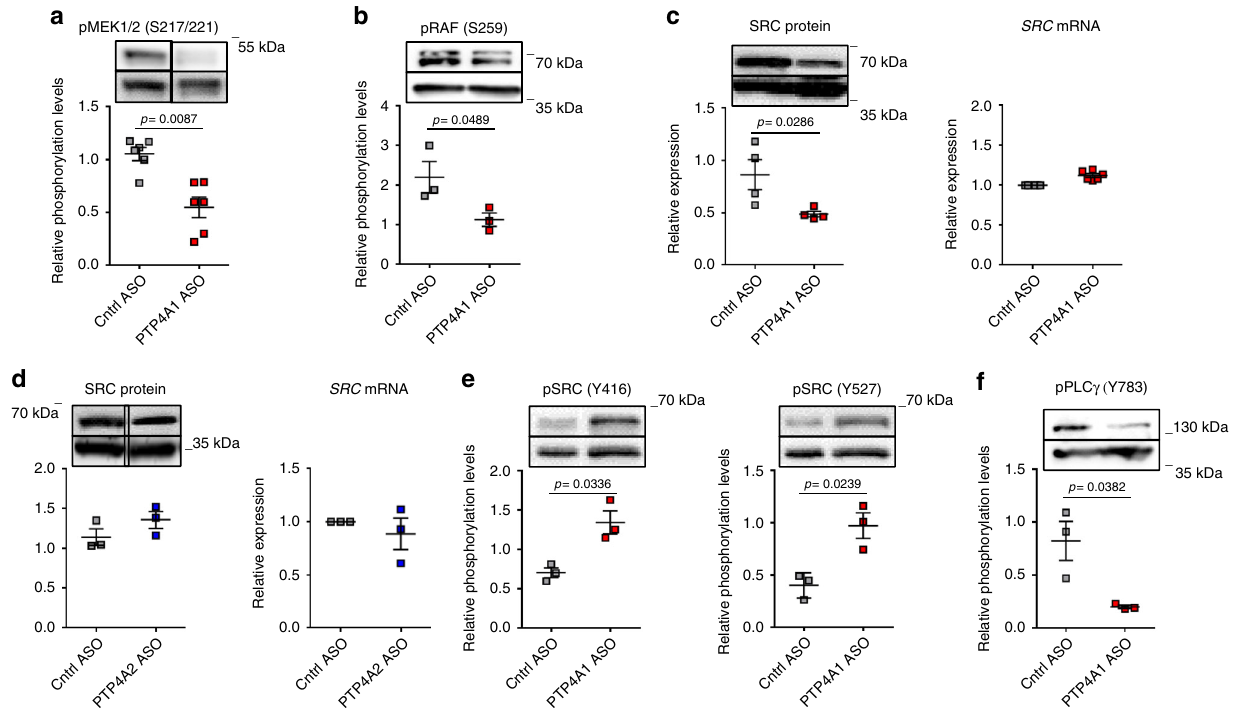
Fig. 6 PTP4A1 enhances SRC half-life and activity in NHDF. a , b Mean ± SEM of densitometric scan expression plus representative immunoblotting for pMEK1/2 (S217/221) or pRAF (S259) (upper bands) normalized to MEK1/2 or GAPDH, respectively (lower bands) in three different NHDF lines treated with control or PTP4A1 ASO. Images are from different lanes on the same membrane. c , d Left graphs show mean ± SEM of densitometric scan expression plus representative immunoblotting for SRC (upper bands) normalized to GAPDH (lower bands) in four different NHDF lines treated with control ASO, PTP4A1 ASO, or PTP4A2 ASO (three different NHDF lines). Right graphs show mean ± SEM of SRC mRNA expression measured in six different NHDF lines treated with PTP4A1 ASO or three different NHDF lines treated with PTP4A2 ASO and normalized to the same lines treated with control ASO. Images are from different lanes on the same membrane. e , f Mean ± SEM of densitometric scan expression plus representative immunoblotting for pSRC (Y416) ( e , left graph, upper bands), pSRC (Y527) ( e , right graph, upper bands), or pPLC γ (Y783) ( f , upper bands) normalized to SRC (lower bands in e ) or GAPDH (lower bands in f ) in three different NHDF lines treated with control or PTP4A1 ASO. Mann – Whitney test ( a ) or Welch ’ s t -test ( b , c , e , f